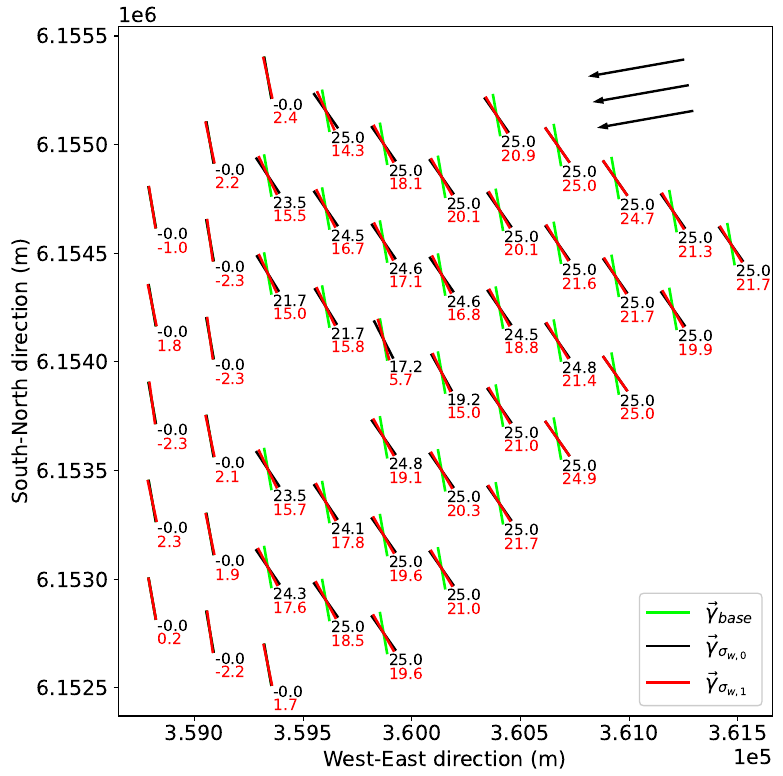
Figure 12. Yaw angles for each turbine in the farm, for a wind direction of 80 ◦ and a wind speed of 8 m/s: deterministic value (the upper number in black) and robust value (the lower number in red). The wind direction is indicated with black